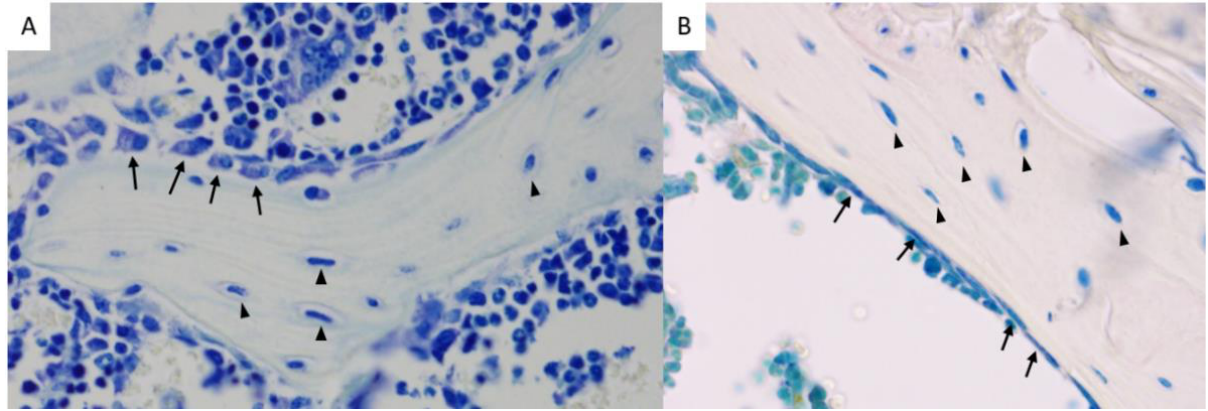
Figure 1. ( A ) Toluidine blue staining of a mouse femur showing osteoblasts (arrows) and osteocytes (triangles) (female, 8 weeks of age, original magnification 400×). ( B ) TRAP and toluidine blue staining of a mouse tibia, showing bone lining cells (arrows) and osteocytes (triangles) (female, 18 weeks of age, original magnification 400×).